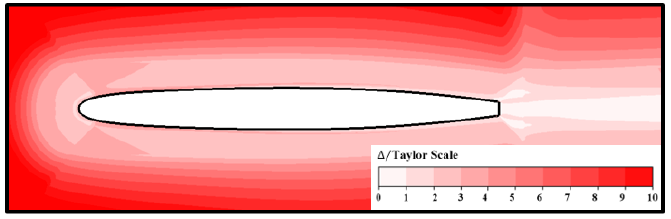
Figure 2. Contour plot of the ratio between the mesh resolution, ∆ , and the Taylor scales. The hydrofoil mean pressure coefficient, 𝐶 (cid:3043) = (cid:3043)(cid:2879)(cid:3043) (cid:3246) , was plotted along the chord as shown (cid:2869) (cid:2870)⁄ (cid:3096)(cid:3023) (cid:3167)(cid:3172)(cid:3170)(cid:3163)(cid:3178)(cid:3118) in Figure 3a where the dimensionless position x / L = 0 corresponds to the center of the hydrofoil chord line. The numerical results were compared with the results obtained with the vortex panel method